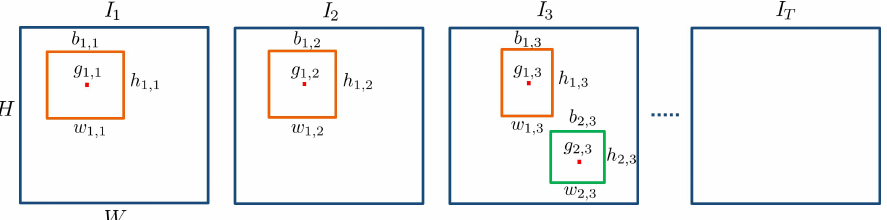
Figure 4. Video with T frames of height H , width W and channels D = 1. Two objects, shown in orange and green bounding boxes, are defined as o 1 = ( { b 1,1 , b 1,2 , b 1,3 } , c 1 ) and o 2 = ( { b 2,3 } , c 2 ) , where c 1 , c 2 ∈ C are the object classes. Here, { b 1,1 , b 1,2 , b 1,3 } are bounding boxes of object 1 on first three frames and { b 2,3 } represents bounding box of object 2 at frame